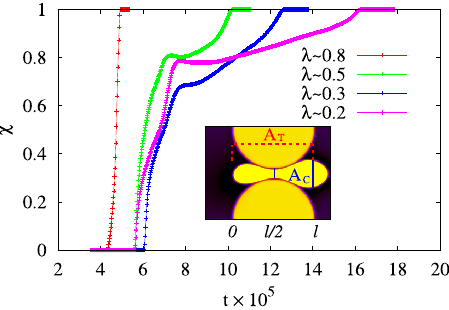
Fig. 7 | Transmigration order parameter. We plot the time evolution of χ ( t )= A t )/ A t ), where A C ( T ( C represents the area fraction of droplet between the centerline (located at l /2) and the exit of the pore (placed at l ), and A T is the total areaofthedropletwithinthepore.If λ ≃ 0.8, χ ( t )growsrapidlytowards1following an approximately linear behavior. For decreasing values of χ one can distinguish three regimes: a fast-growing approximately linear one at the entry of the pore, a short stationary one (lasting longer for narrower interstices) with a temporary negative slope in the middle, and a fi nal slow-growing one at the exit. The inner snapshot shows an instantaneous con fi guration of the transmigration with λ ≃